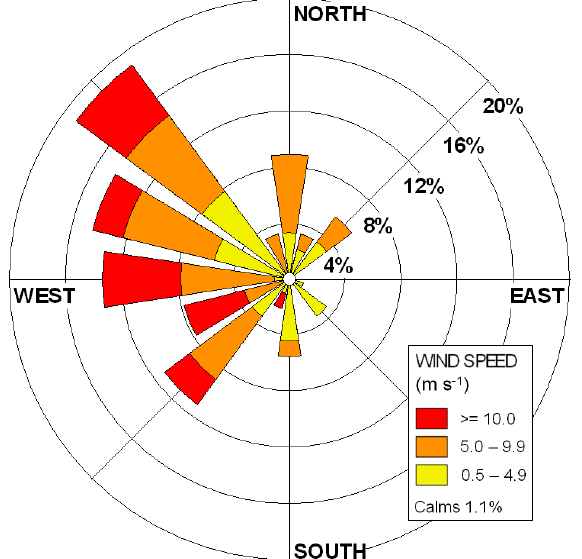
Figure 5. Wind rose diagram showing the percent frequency of rawinsonde-derived 850 hPa wind directions (16 bins) and wind speeds (light = yellow, moderate = orange, and strong = red) for 90 days during BAQS-Met. Note that on one day the synoptic wind was calm and that there were no occurrences from the east-northeast, east, or south-southeast.